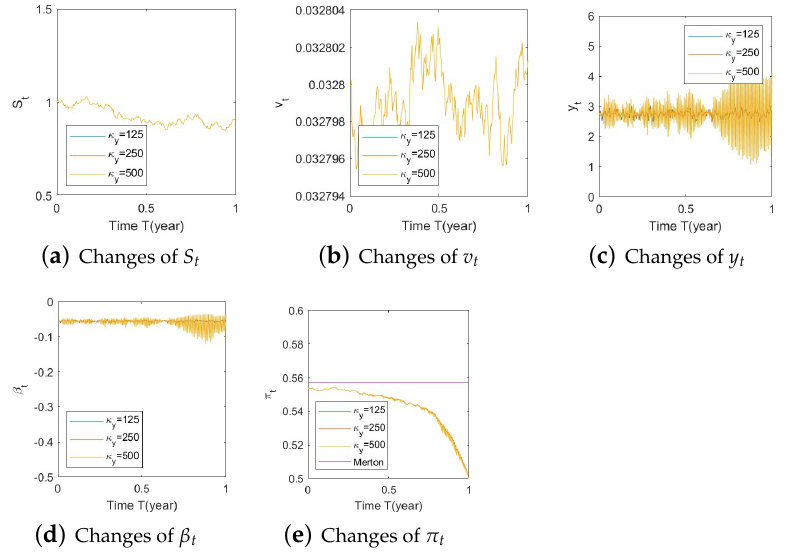
Figure A16. Illustrate the impact on ( a ) stock prices, ( b ) driver of volatility, ( c ) driver of elasticity, ( d ) elasticity of volatility, and ( e ) optimal stock allocations when varying the speed of reversion, κ y ( e . g ., κ y = 125,250,500 ) .